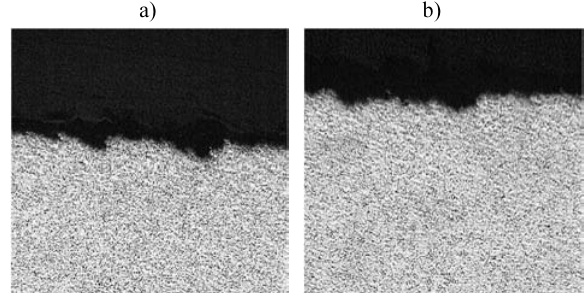
Fig. 4. Corroded edges of sheets in 25-times magnifica- tion: a) sheet from tank No. 3, b) sheet from tank No. 4. Etched with Nital solution. Dark areas in upper part of photography – resin with which samples were covered be- fore executing polished